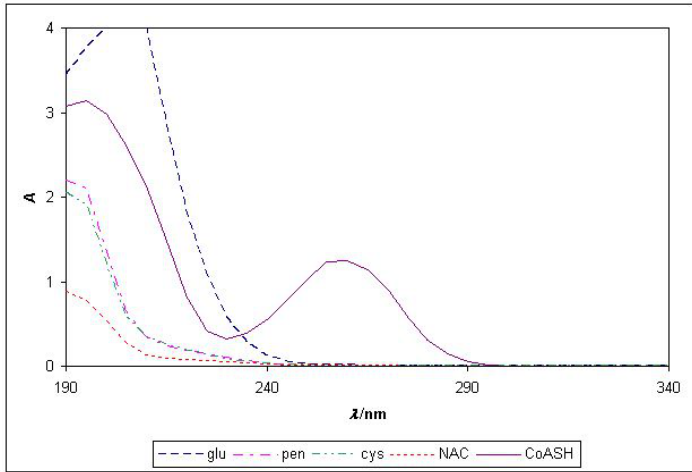
Figure 6. Absorption spectra of different thiols from 190 to 340 nm, c = 1.0x10 -4 M, λ (CoASH) = 258 nm.